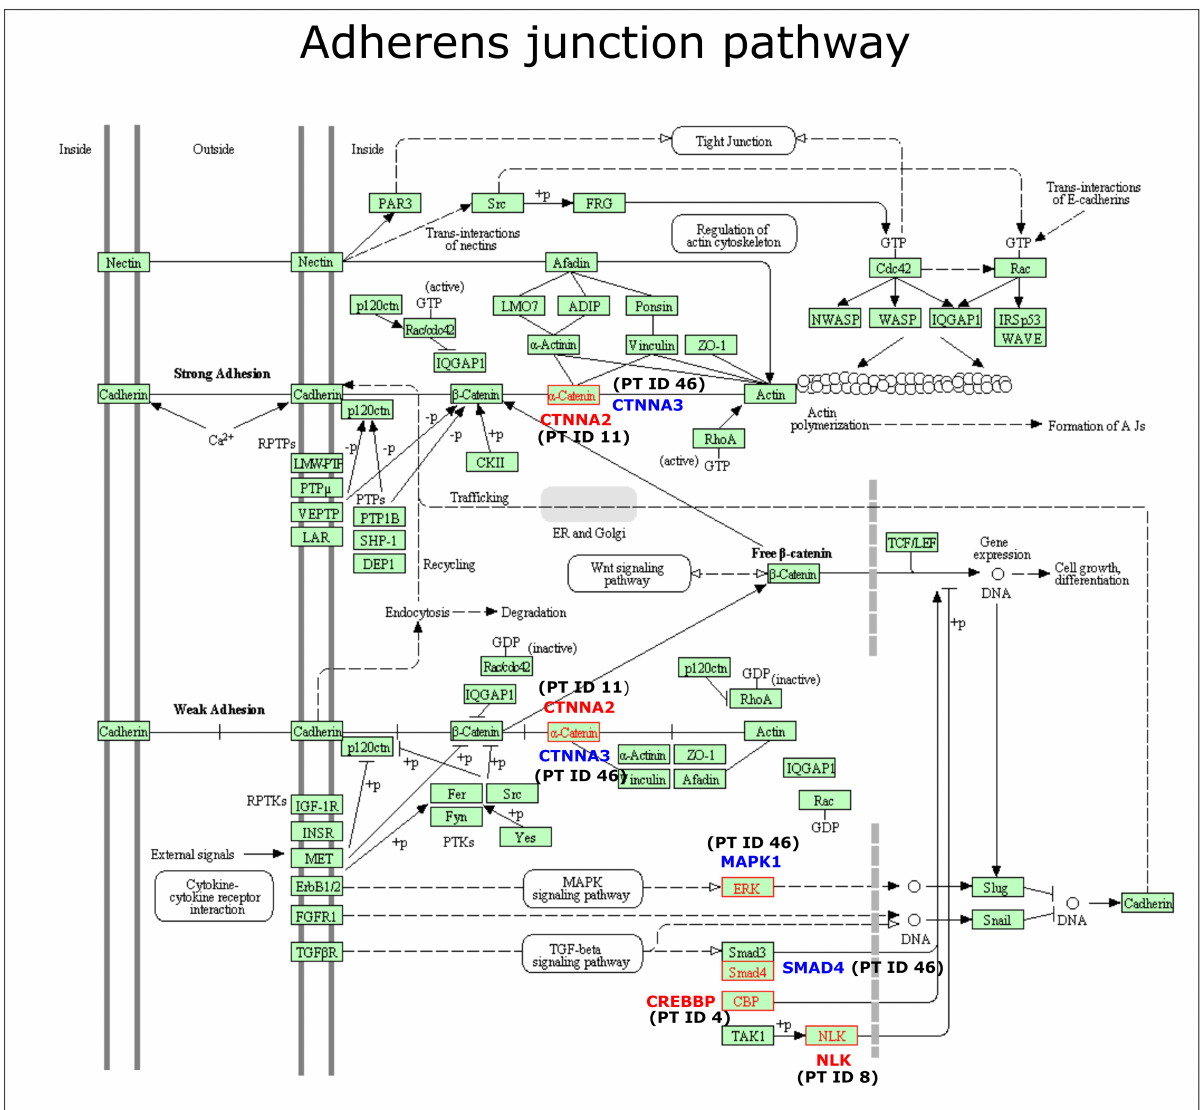
Fig 2. KEGG Adherens junction pathway, which is affected exclusively in the metastases of three of the studied patients (gene names in red), and affected by shared mutations between primary tumor and metastasis in one patient (gene names in blue). CTNNA2 and CTNNA3 are both encoding α -catenins. Patient IDs are in